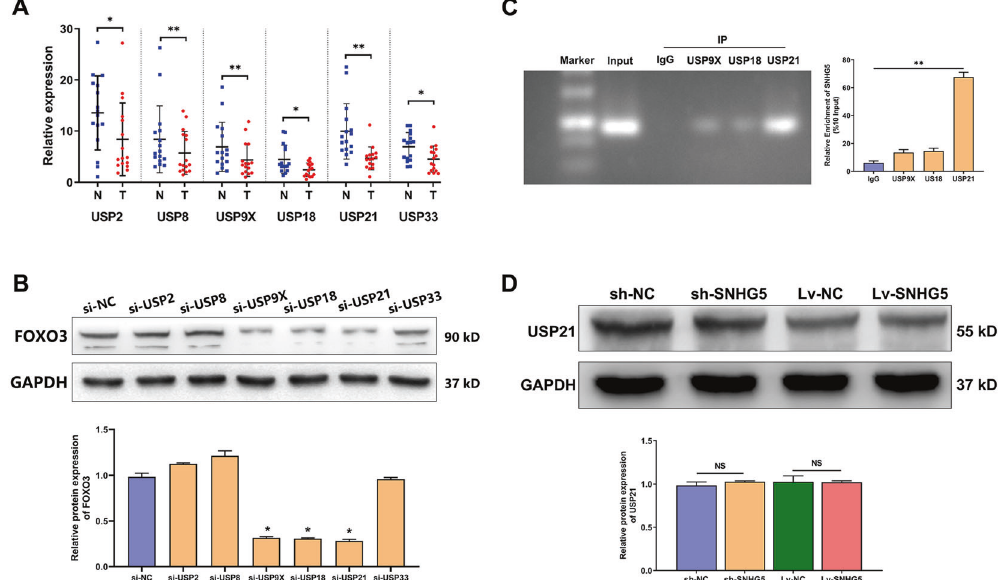
Fig. 6 SNHG5 regulates FOXO3 expression by recruiting USP21. A The relative mRNA expression of potential USP-family DUBs in 24 paired PTC tissues and adjacent non-cancerous tissues. B FOXO3 abundance assessed by WB in TPC1 cells transfected with siRNAs targeting respective DUBs. C The enrichment of SNHG5 in anti-USP21 precipitates shown in RIP assay. D The protein level of USP21 detected in PTC cells with SNHG5 knockdown or upregulation. tumors was observed every 6 days from the 12th day after downregulation resisted the increase of FOXO3 expression caused injection. The tumor volume was calculated based on the long by RBM47 overexpression (Fig. 4C). To clarify whether RBM47 diameter and short diameter measured by Vernier caliper. The in fl uences tumor growth via SNHG5 in vivo, TPC1 cells stably results showed that the size, volume, and weight of xenograft transfected with NC, Lv-RBM47, or Lv-RBM47 + sh-SNHG5 were tumors in the Lv-RBM47 group were remarkably lower than those injected into the backs of nude mice. The growth of subcutaneous